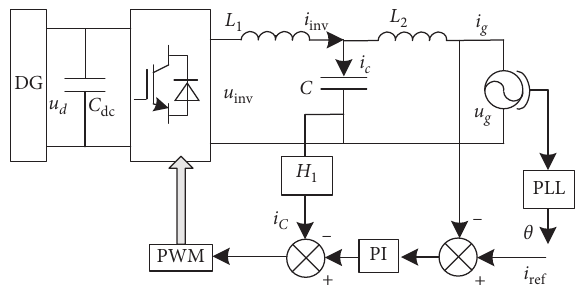
Figure 1: Control structure of the grid-connected